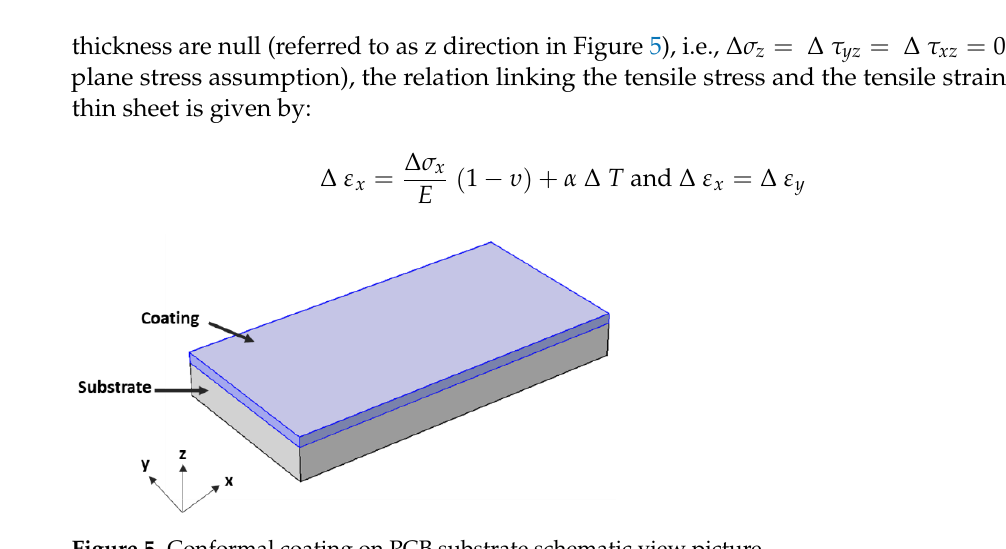
Figure 5. Conformal coating on PCB substrate schematic view